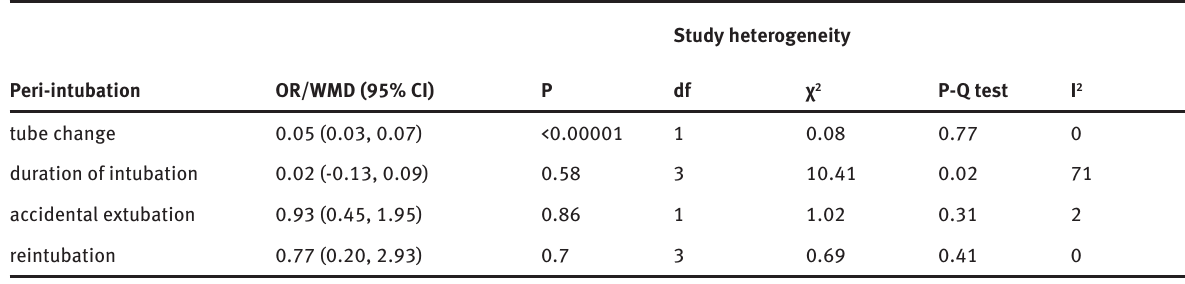
Table 2: The meta-analysis results of peri-procedure parameters.